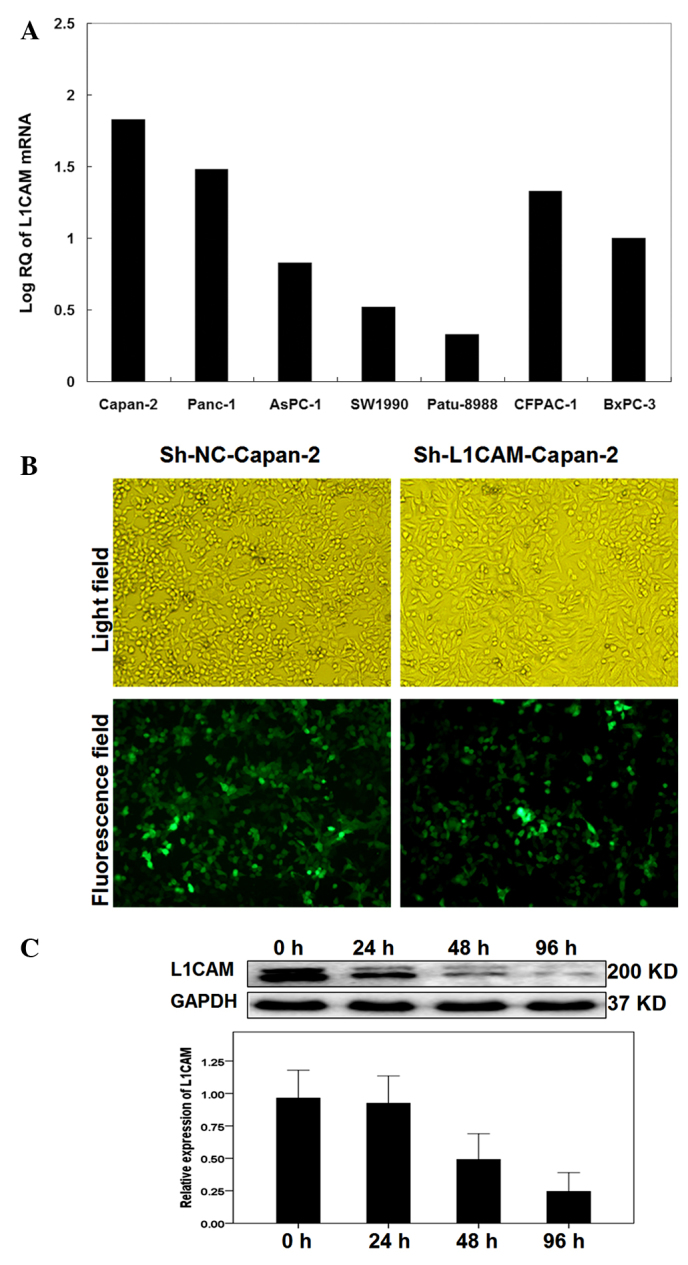
Lentivirus-mediated RNA interference decreased L1CAM expression in the pancreatic cell lines. (A) Polymerase chain reaction showed that human L1CAM mRNA was present in seven pancreatic cancer cell lines, Capan-2, PANC-1, AsPC-1, BxPC-3, SW-1990, Patu-8988 and CFPAC-1. L1CAM mRNA expression levels were highest in the Capan-2 cells and lowest in the Patu-8988 cells. (B) Light micrograph (top) and fluorescence micrograph (bottom) images (magnification, ×200). The transduction efficiency in the Capan-2 cells was estimated 96 h after infection and the intensity of fluorescence indicated a high transfection efficiency. (C) Western blot analysis of total cellular proteins extracted from Capan-2 cells at 0, 24, 48, 72 and 96 h after infection and targeted by antibodies against L1CAM, showed that the L1CAM protein levels decreased in a time-dependent manner. GAPDH served as the internal control. Data represents one of three independent experiments. L1CAM, L1 cell adhesion molecule; NC, negative control; Sh, short hairpin; RQ, relative quantity.